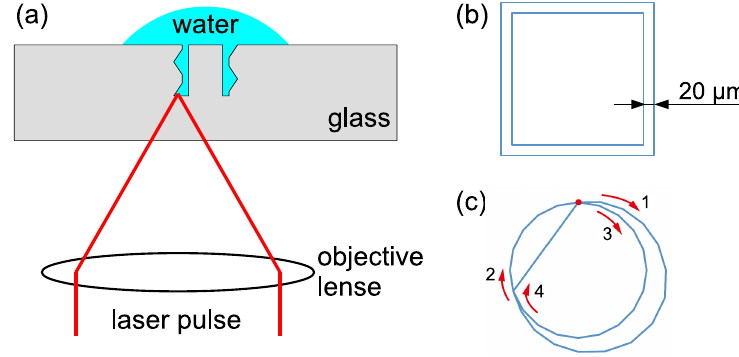
Figure 1. ( a ) Schematic view of water-assisted laser drilling; ( b ) The trajectory of the laser focus at each z -plane for a hole with a square cross-section; ( c ) The trajectory of the laser focus at each z -plane for an internal thread. The numbers indicate the order of the